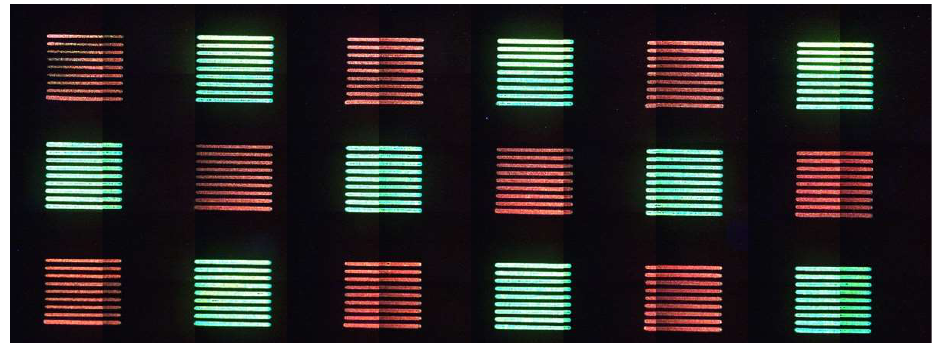
Figure 11. Fluorescence microscope image of the red/green chessboard obtained by using for red squares a laser power of 160 mW, pulse frequency of 100 kHz, speed 20 mm/s and loop count 1 that means a dose of 34.6 J/cm 2 . The green squares are obtained by using a laser power of 350 mW, pulse frequency 20 KHz, speed 100 mm/s and loop count 3 that means a dose of 44.8 J/cm 2 . The presence in the same film of green and red-emitting CdTe QDs is witness to the fact that keeping the chemical film composition constant, and just modulating the dose and repetition rate, makes it possible to obtain CdTe QDs emitting different colors. To our knowledge, this is the first result showing the laser synthesis of QDs’ emission from green to red in solid-state. Similar results are shown for perovskite QDs, with some differences from the present work. Indeed, Zhan et al. [40] obtained only red-emitting perovskite QDs